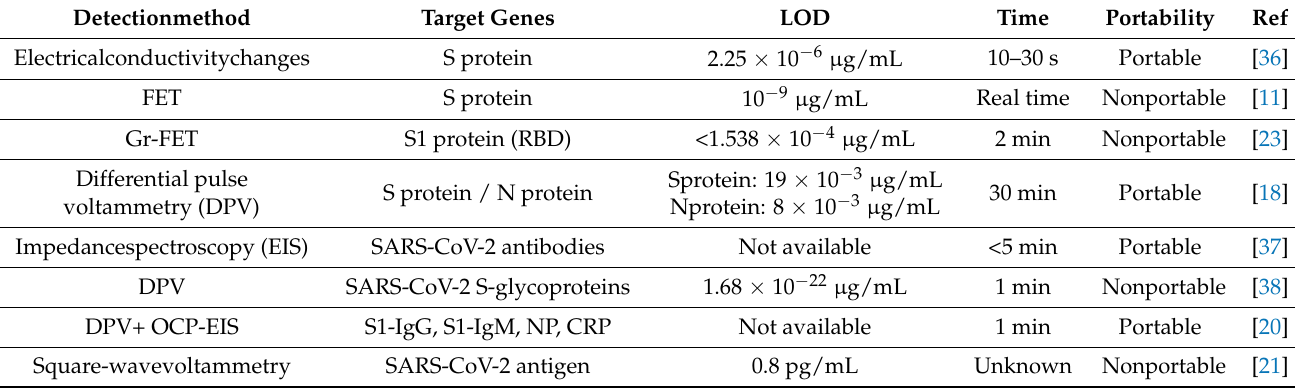
Table 1. Electrochemical biosensors for SARS-CoV-2 detection.